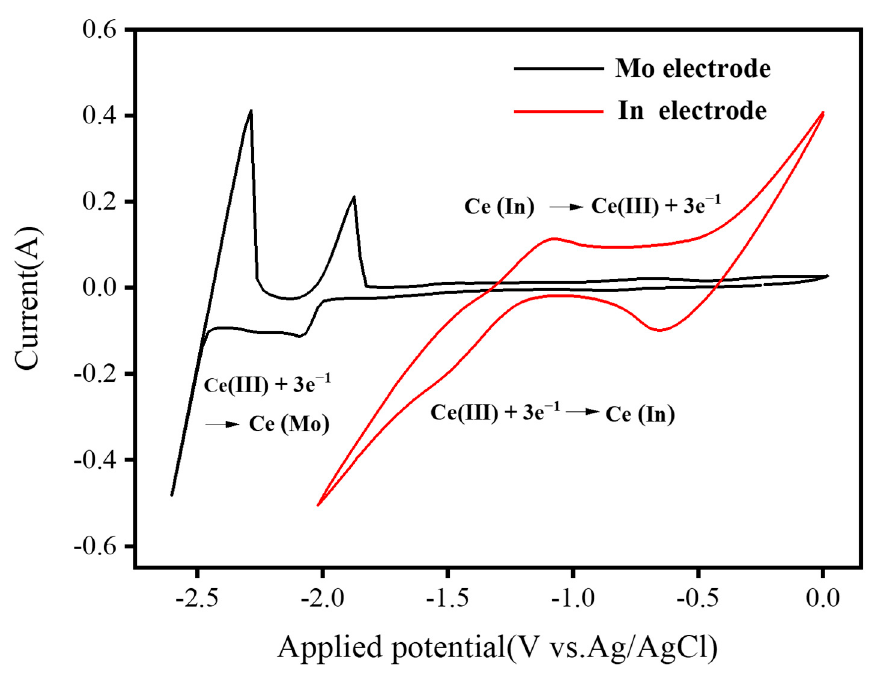
Figure 2. Comparison between cyclic voltammetry of LiCl-KCl-CeCl 3 melt at 723 K at molybdenum and liquid indium metal electrodes, respectively; sweep rate: 100 mV s − 1 .